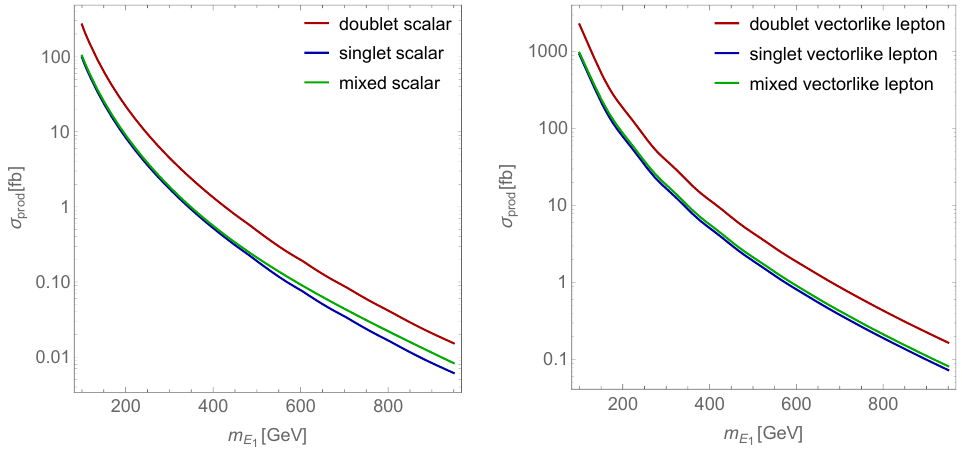
Figure 1 . The pair production cross sections of the lightest sleptons (left) and the vectorlike leptons (right) with p s = 13 TeV.